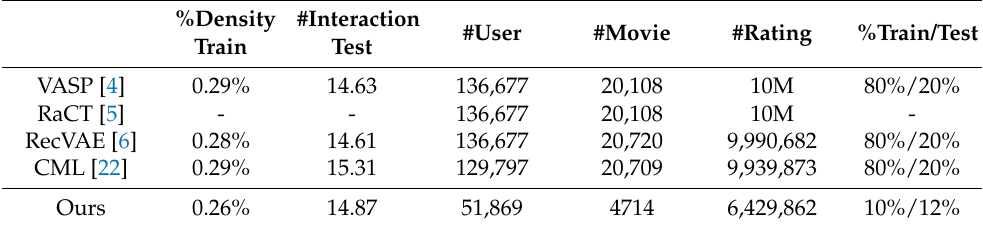
Table 1. Comparison table with data environment of baselines. % Density Train means the density of the training dataset in the corresponding methods. #Interaction Test means the average number of ratings for each user used in the test stage. #User, #Movie, and #Rating are the number of preprocessed datasets in each method. % Train/Test is the ratio of the train (and valid) set/test set, including Held-out data.